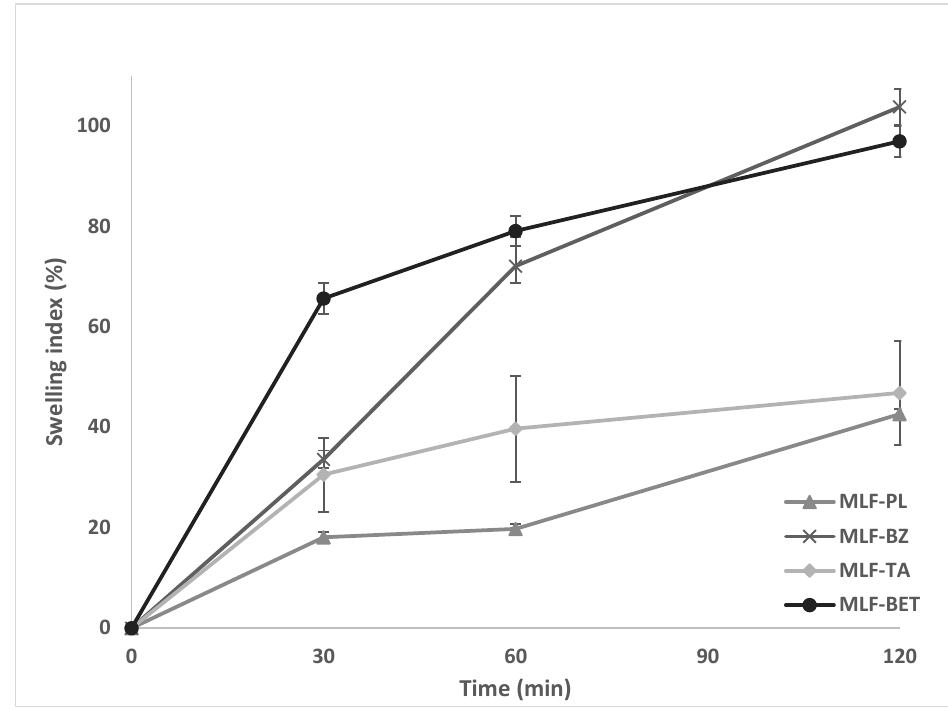
Figure 1. Swelling index of multilayer casein/chitosan films loaded with benzydamine hydrochloride (MLF-BZ), tolfenamic acid (MLF-TA) and betahistine dihydrochloride (MLF-BET) compared to drug-free (placebo) films (MLF-PL), n = 3.